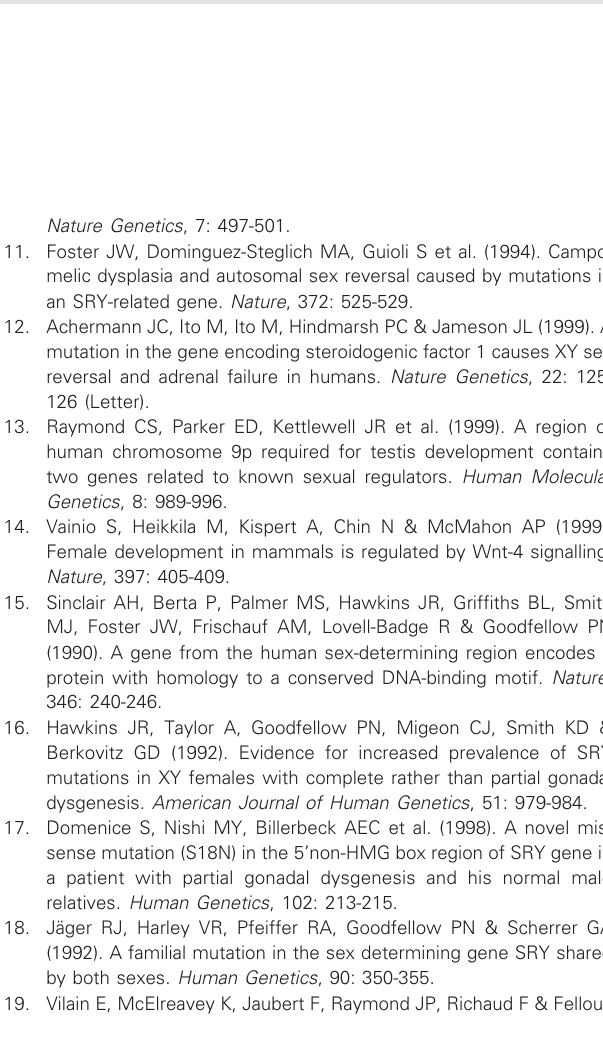
ETRS = embryonic testicular regression syndrome; PDG = partial gonadal dysgenesis. *Number of patients with molecular alterations/total number of studied